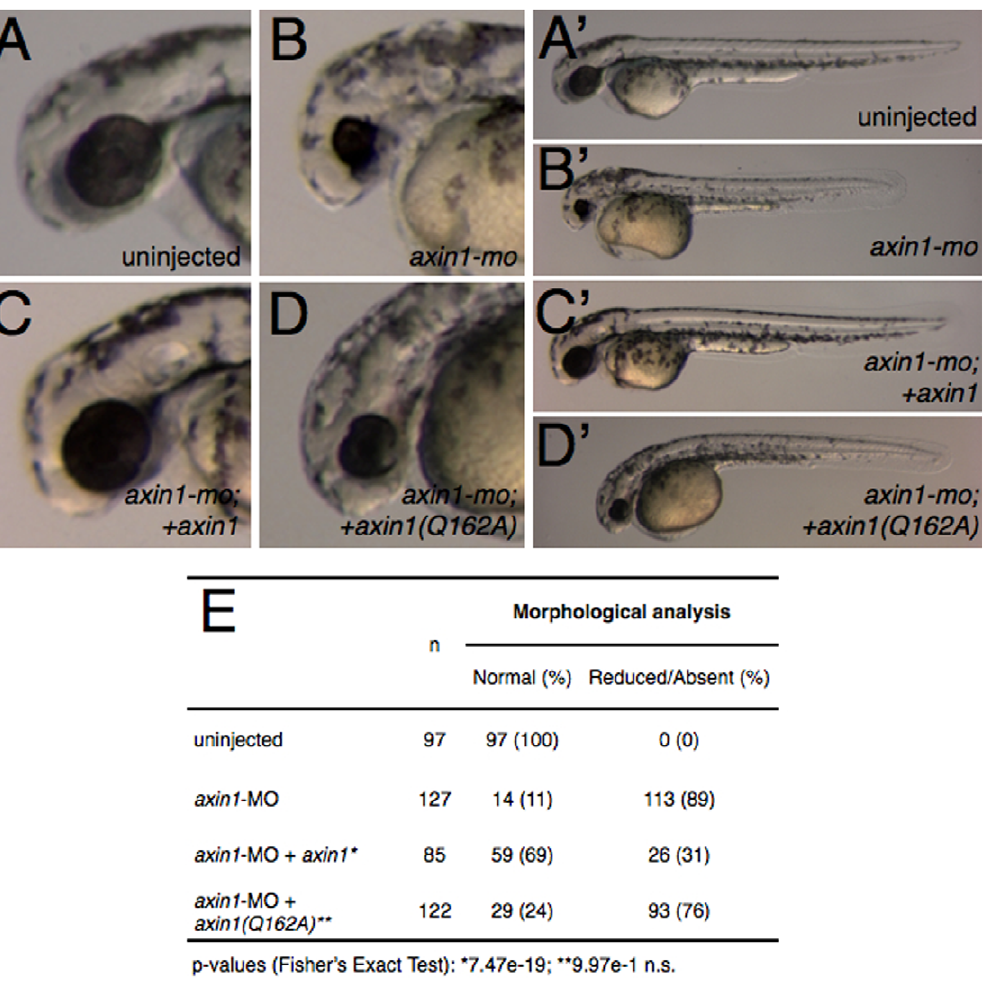
Figure 5. axin1 but not axin1(Q162A) rescues anterior defects in Axin1-depleted embryos. ( A–D 9 ) Representative phenotypes of control and Axin1-depleted zebrafish embryos. ( A ) control uninjected embryo, ( B ) Axin1-depleted embryo (4 ng axin1 -MO), ( C ) MO injected embryo coinjected with 25 pg axin1 mRNA, ( D ) MO injected embryo coinjected with 25 pg axin1(Q162A) mRNA. ( E ) Summary table of morphological defects.